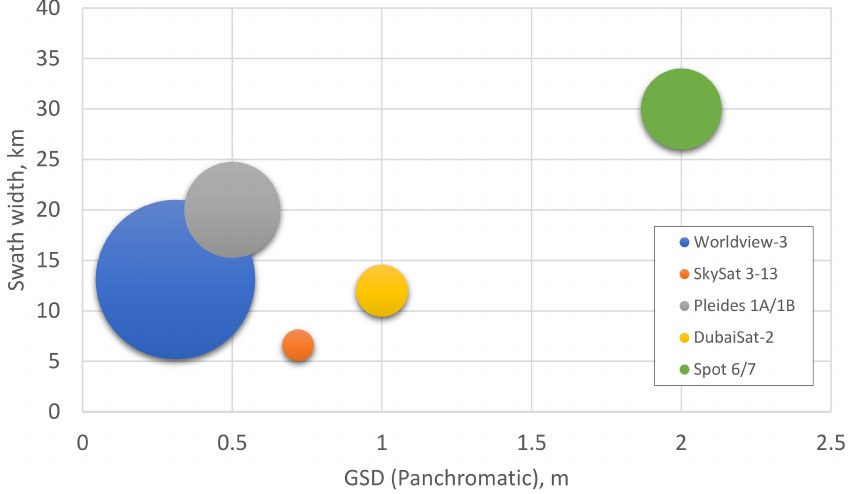
Figure 4. Panchromatic spatial resolution versus swath width for existing high-resolution satellite systems. Bubble size indicates spacecraft